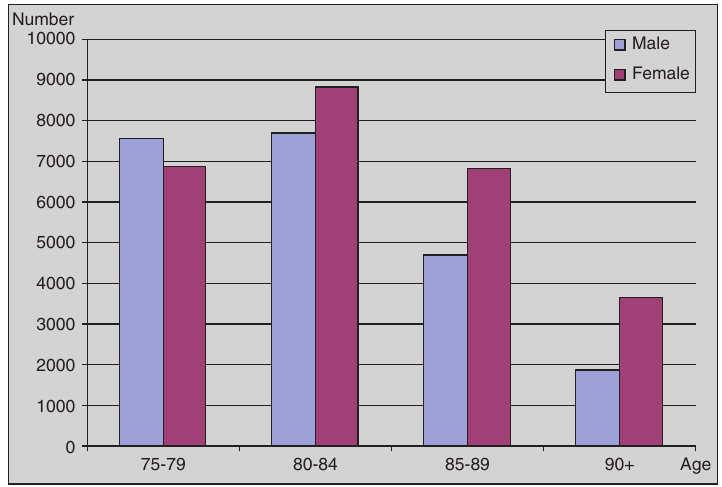
Figure 3. Distribution by age and sex of multiple-diseased elderly patients with at least one diagnosis of a cardio v ascular